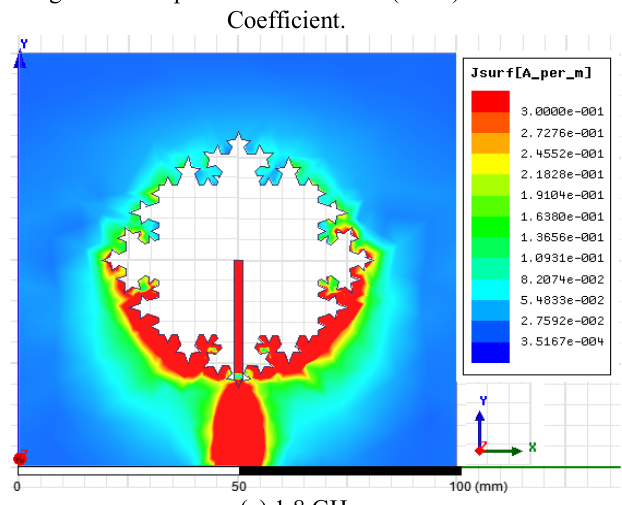
Figure 8. Comparison of Antenna 2 (IO=2) Reflection